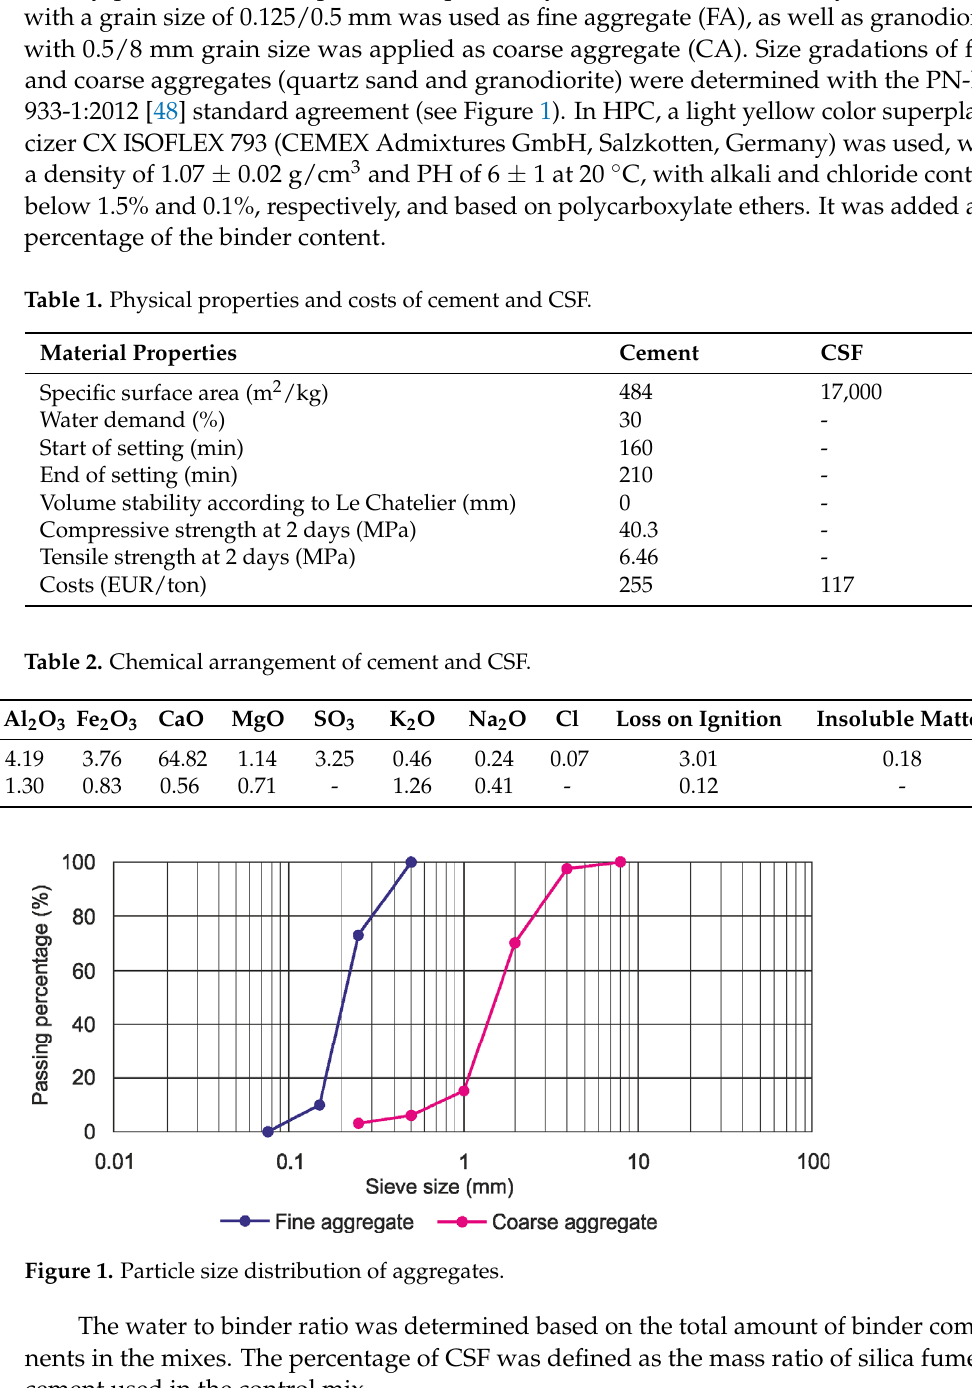
Table 2. Chemical arrangement of cement and CSF.